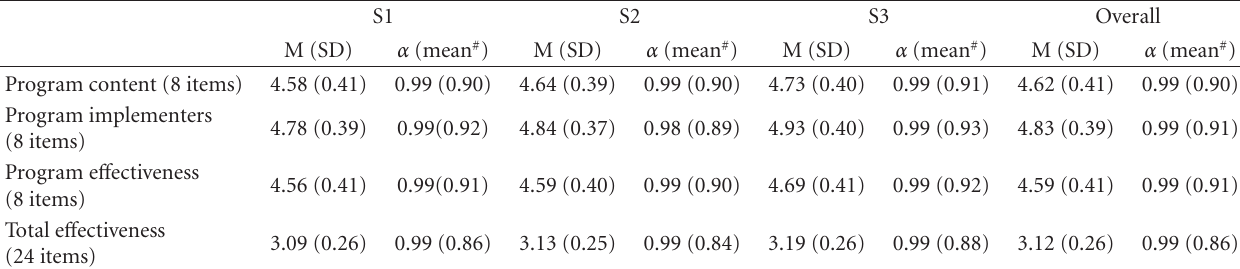
Table 6: Means, standard deviations, Cronbach’s alphas, and mean of interitem correlations among the variables by grade.